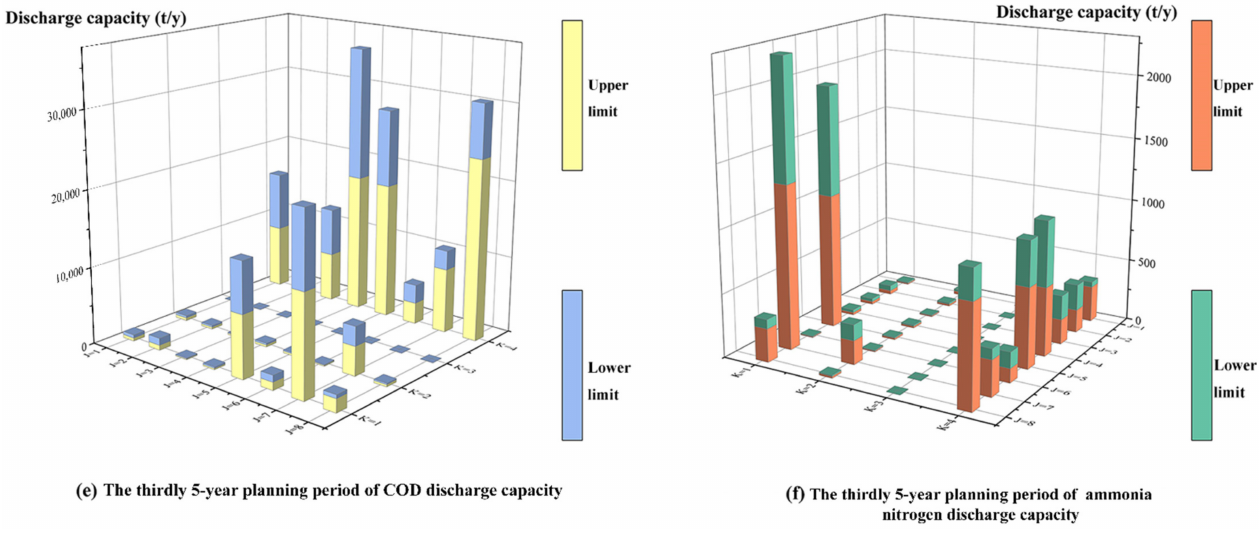
Figure 2. COD and ammonia emissions by water-use sectors in the Yinma River Basin for different planning periods. ( a ) The first 5-year planning period of COD discharge capacity by water-use sectors in the Yinma River Basin ( b ) The first 5-year planning period of ammonia emissions discharge capacity by water-use sectors in the Yinma River Basin ( c ) The second 5-year planning period of COD discharge capacity by water-use sectors in the Yinma River Basin ( d ) The second 5-year planning period of second ammonia emissions discharge capacity by water-use sectors in the Yinma River Basin ( e ) The third 5-year planning period of COD discharge capacity by water-use sectors in the Yinma River Basin ( f ) The third 5-year planning period of ammonia emissions discharge capacity by water-use sectors in the Yinma River